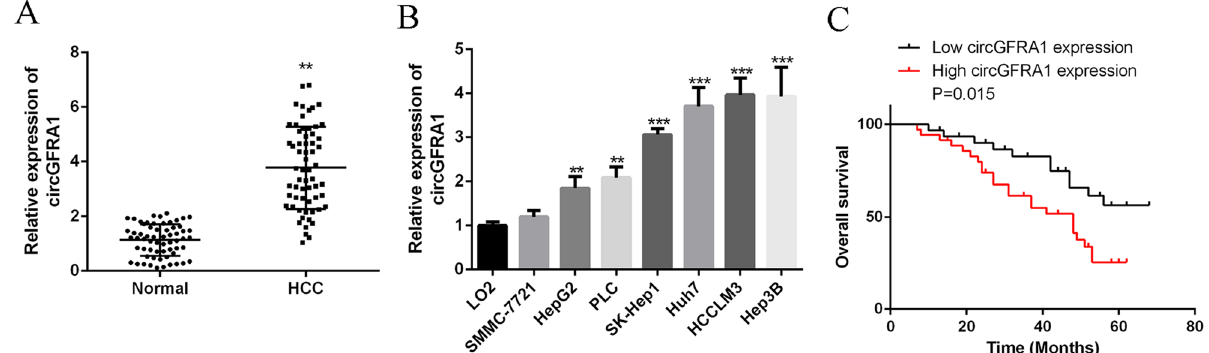
Figure 1. CircGFRA1 was markedly over-expressed in HCC. ( A ) qRT-PCR for circGFRA1 in HCC tissues and adjacent healthy tissues (n = 62). ( B ) mRNA of circGFRA1 in HCC cell lines and normal liver cell line by qRT- PCR. ( C ) Kaplan–Meier plots of HCC patients with low (n = 31) and high (n = 31) circGFRA1 expressions. Using median circGFRA1 values as the cutoff. **P < 0.01, ***P <